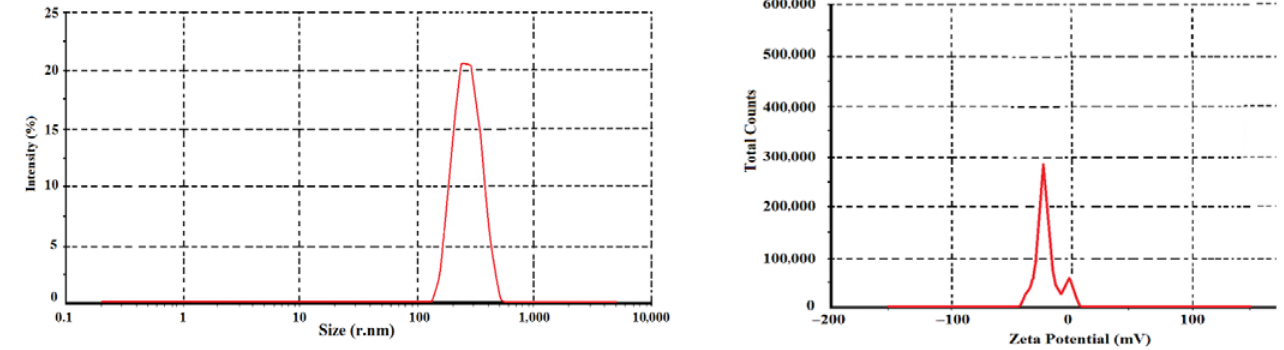
Figure 6. Distribution pattern of erythromycin ‐ loaded PLGA